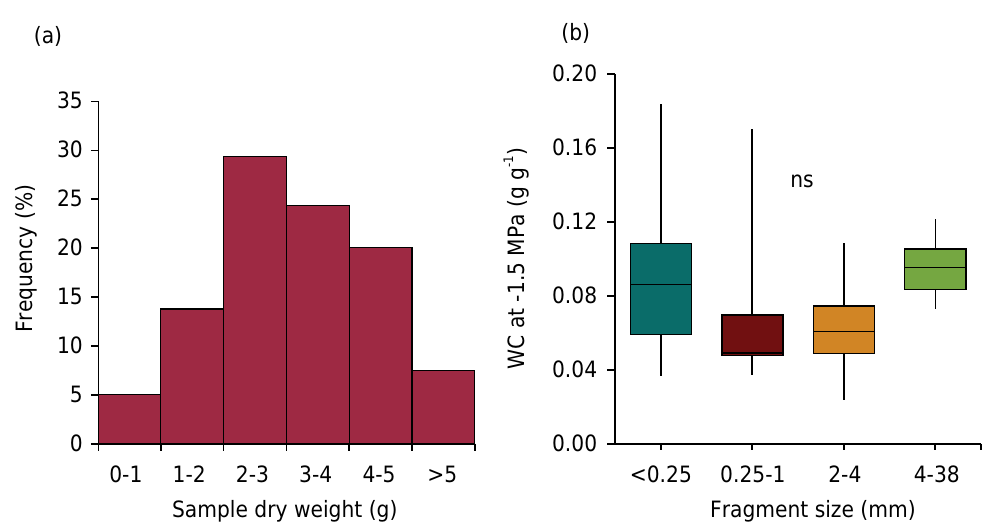
Figure 5. Frequency of saprolite sample weight classes (a) and distribution of water content (WC) estimated at -1.5 MPa with the fitted power function WC = a|Ψ| b in saprolite samples with different sizes (b). n = 10 in each size class; ns = not significant by the F test of ANOVA at p = 0.05.